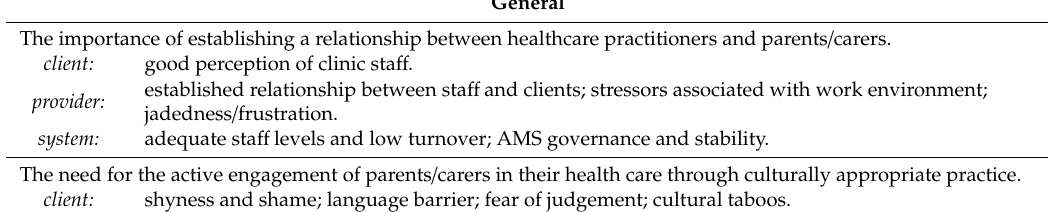
Table 6. Summary of factors that facilitate health service utilisation and associated themes.